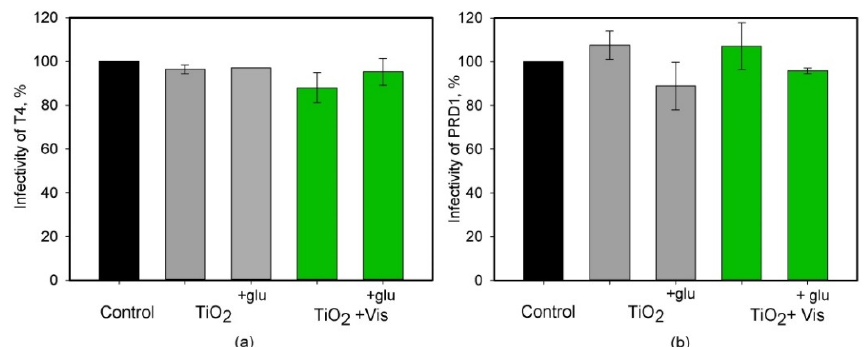
Figure 8. The effect of glucose on antimicrobial properties of TiO 2 against bacteriophages: ( a ) T4; ( b ) PRD1. Experiments were performed in PBS buffer, pH 7.4. with (+glu)/without 0.1% of glucose. The concentration of bacteriophages was 1 x10 3 pfu/mL (plaque-forming unit/mL) and concentration of TiO 2 –0.3 mg/L.